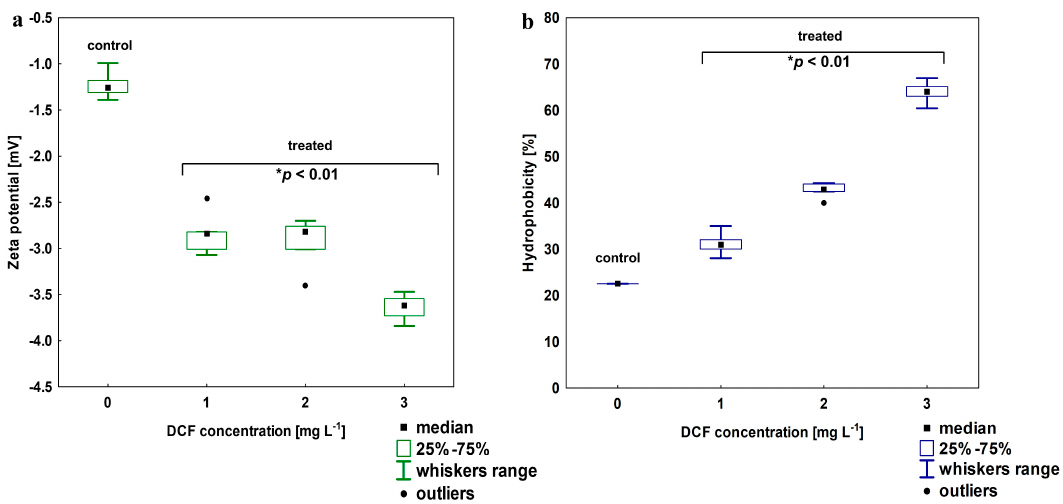
Figure 3. ( a ) Changes in zeta potential for DCF-treated cells at a concentration of 1, 2 and 3 mg L − 1 ; ( b ) changes in the cells wall hydrophobicity in DCF-treated cells at the same range of concentration. For all treatments, the observed changes between treated and control cells were statistically significant (one-way ANOVA followed by the least significant differences (LSD) test with a p -value < 0.01).